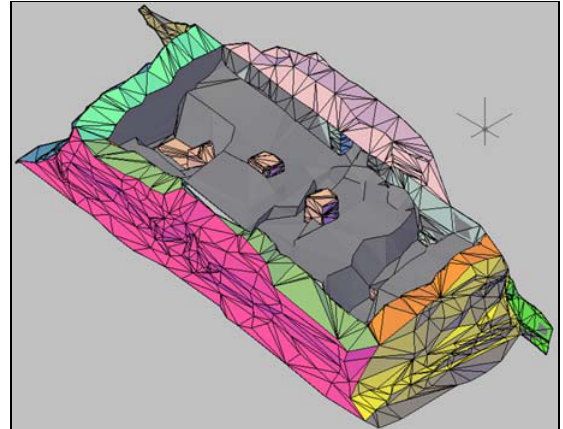
Figure 9. 3D model of the Large Tower obtained from the junction of the outside and inside 3D faces - as resulted from PhotoModeler - and the connecting 3D faces between them.